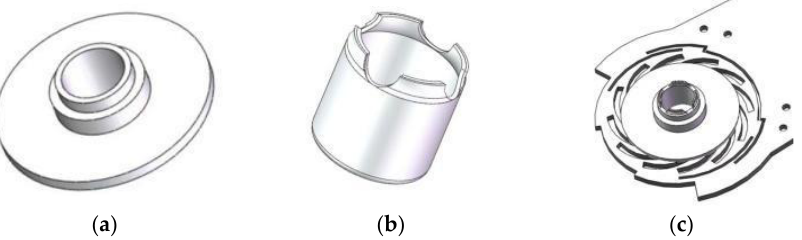
Figure 1. ( a ) Three-dimensional structure diagram of sleeve, ( b ) 3D structure diagram of hohlraum, ( c ) 3D structure diagram of half-hohlraum component.